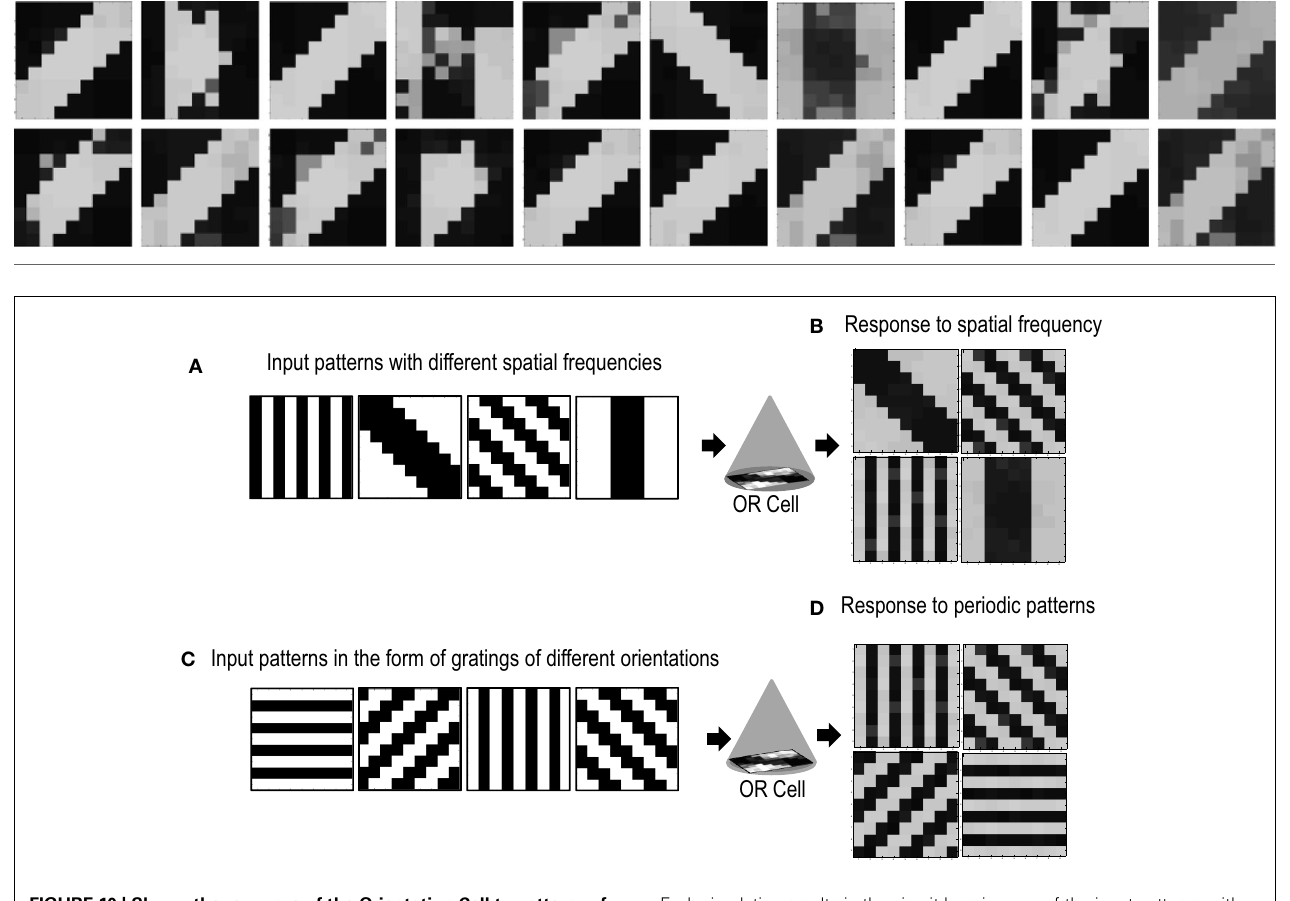
Each simulation results in the circuit learning one of the input patterns with equal probability. (C) Shows periodic patterns of different orientations that are applied as inputs to the OR cell. (D) Shows the periodic patterns that the cell